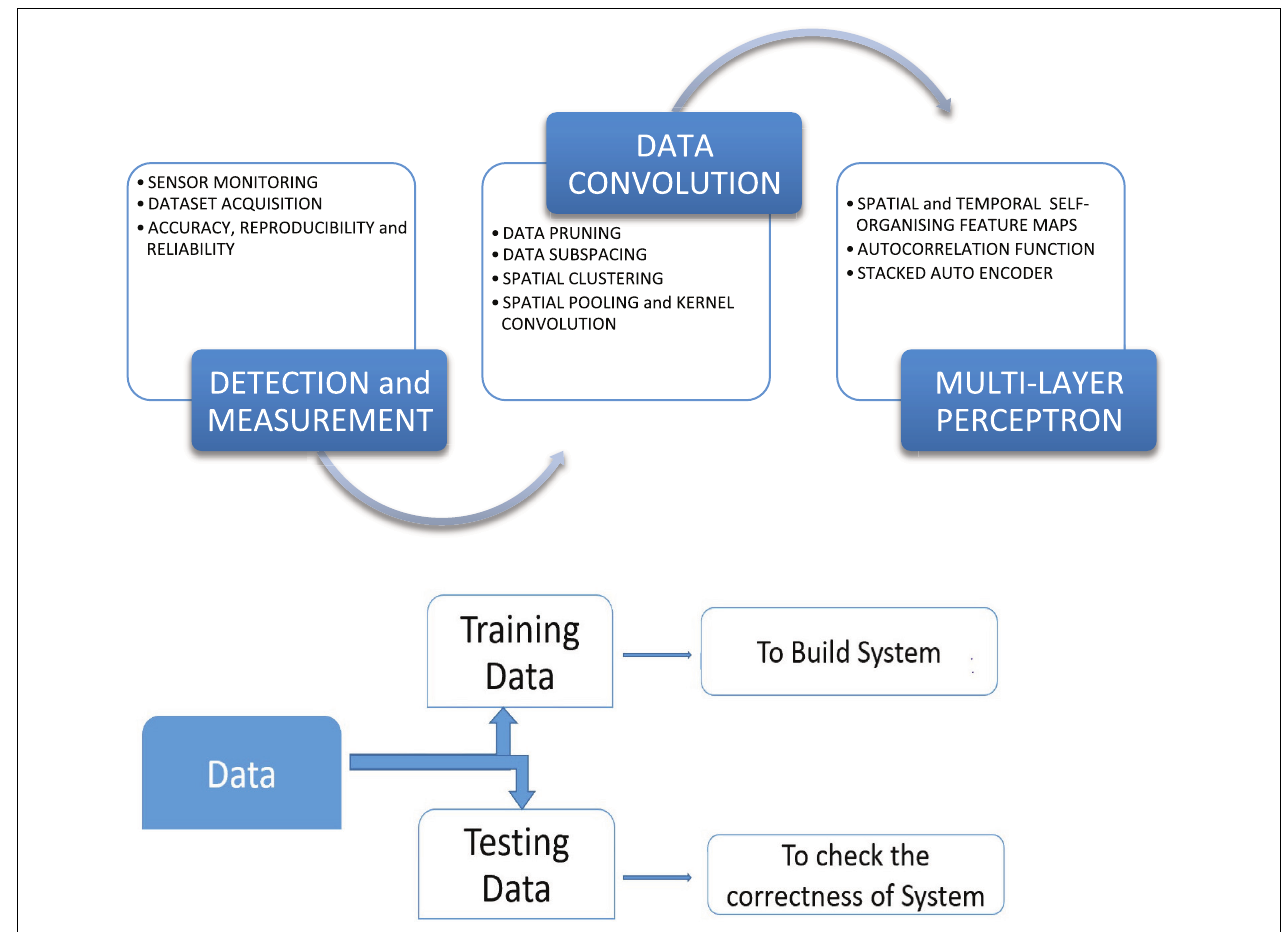
FIGURE 3 | (A) Construction of a digital platform for environmental data analysis: (i) multiple parallel sensor data gathering, (ii) spatial and Temporal Trend Evaluation through input and output data convolutions, and (iii) pattern recognition by unsupervised and supervised deep-learning. (B) Application and installation of the digital platform for environmental data analysis (i) Training: 4 × task algorithm development in 2 × test domains (ii) Testing: (i) emissions bubble(s), (ii) hybrid energy input and output energy flows. A digital platform for environmental data analysis: build-train-test